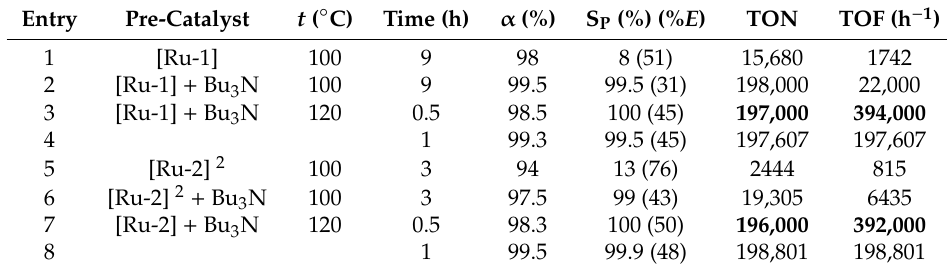
The e ff ectiveness of [RuClH(CO)(PPh 3 ) 3 ] ([Ru-1]) and [RuCl 2 (PPh 3 ) 3 ] ([Ru-2]) in the solvent-free isomerization of hydroperoxide-free -free 4-allyloxybutan-1-ol to (Z)- and ( E )-4-(1-propenyloxy)butan-1-ol: the optimization of the reaction conditions 1